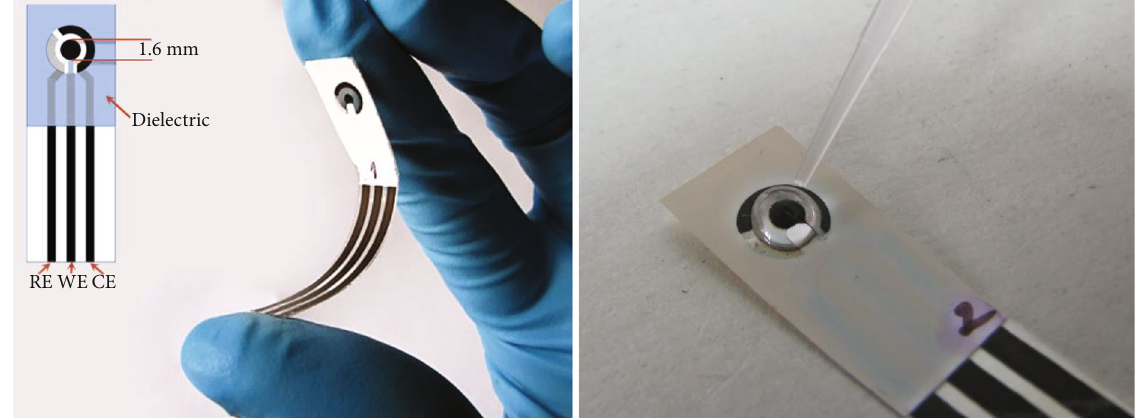
Figure 1: The illustration of the screen-printed devices with a three-electrode con fi guration.